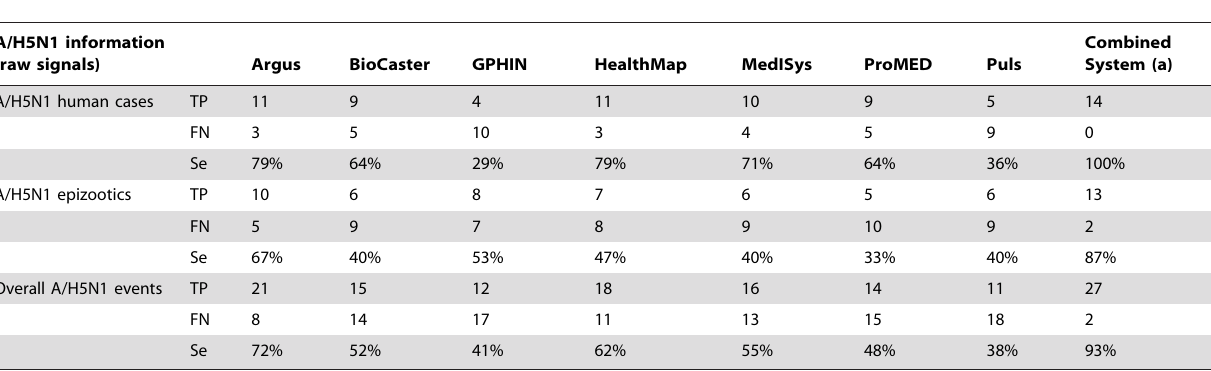
Table 5. Sensitivity of the systems for A/H5N1 cases (overall, human, epizootic) notified by WHO and OIE in March 2010.